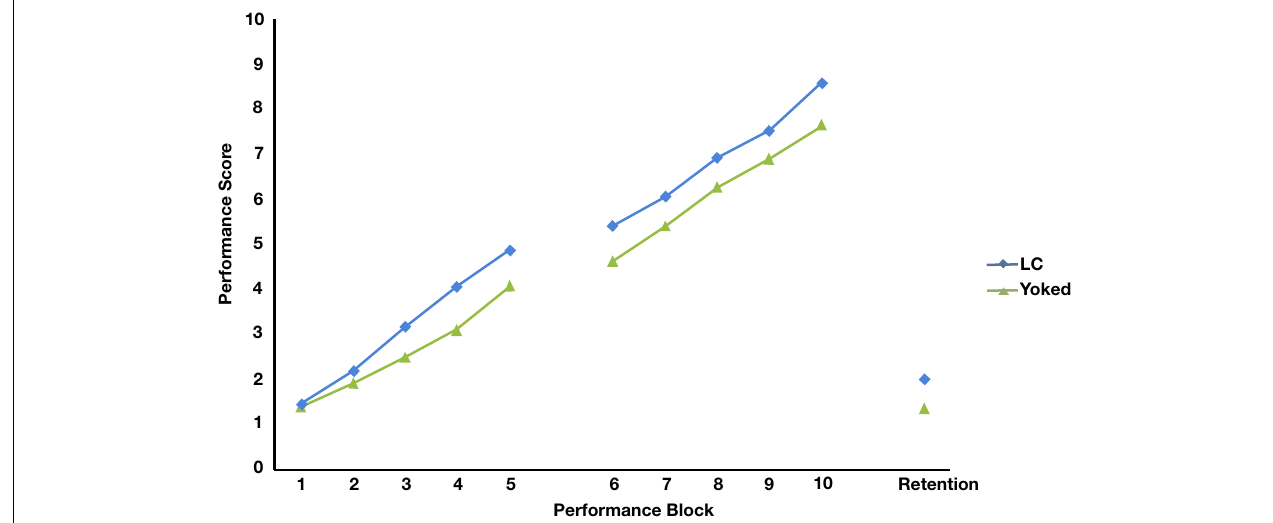
trail block. Performance scores in retention reflect the sum of the number of progression levels advanced during retention and percentage of criteria attained towards the next progression